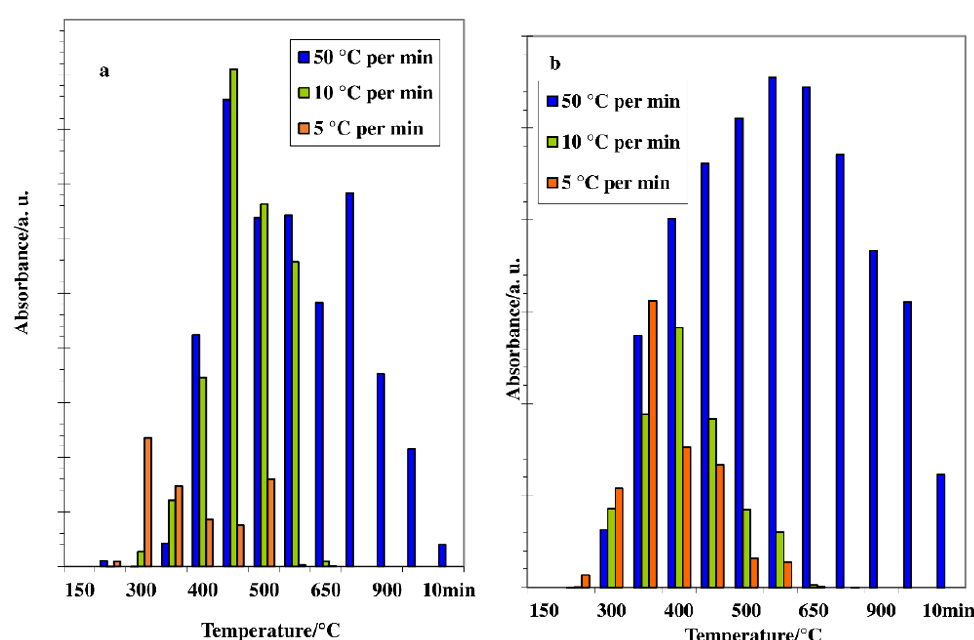
Figure 4. Emission profiles of methane (3014 cm − 1 ) ( a ) and chlorobenzene (742 cm − 1 ); ( b ) emitted in the thermooxidative decomposition of oil shale samples (10 °C min − 1 ).